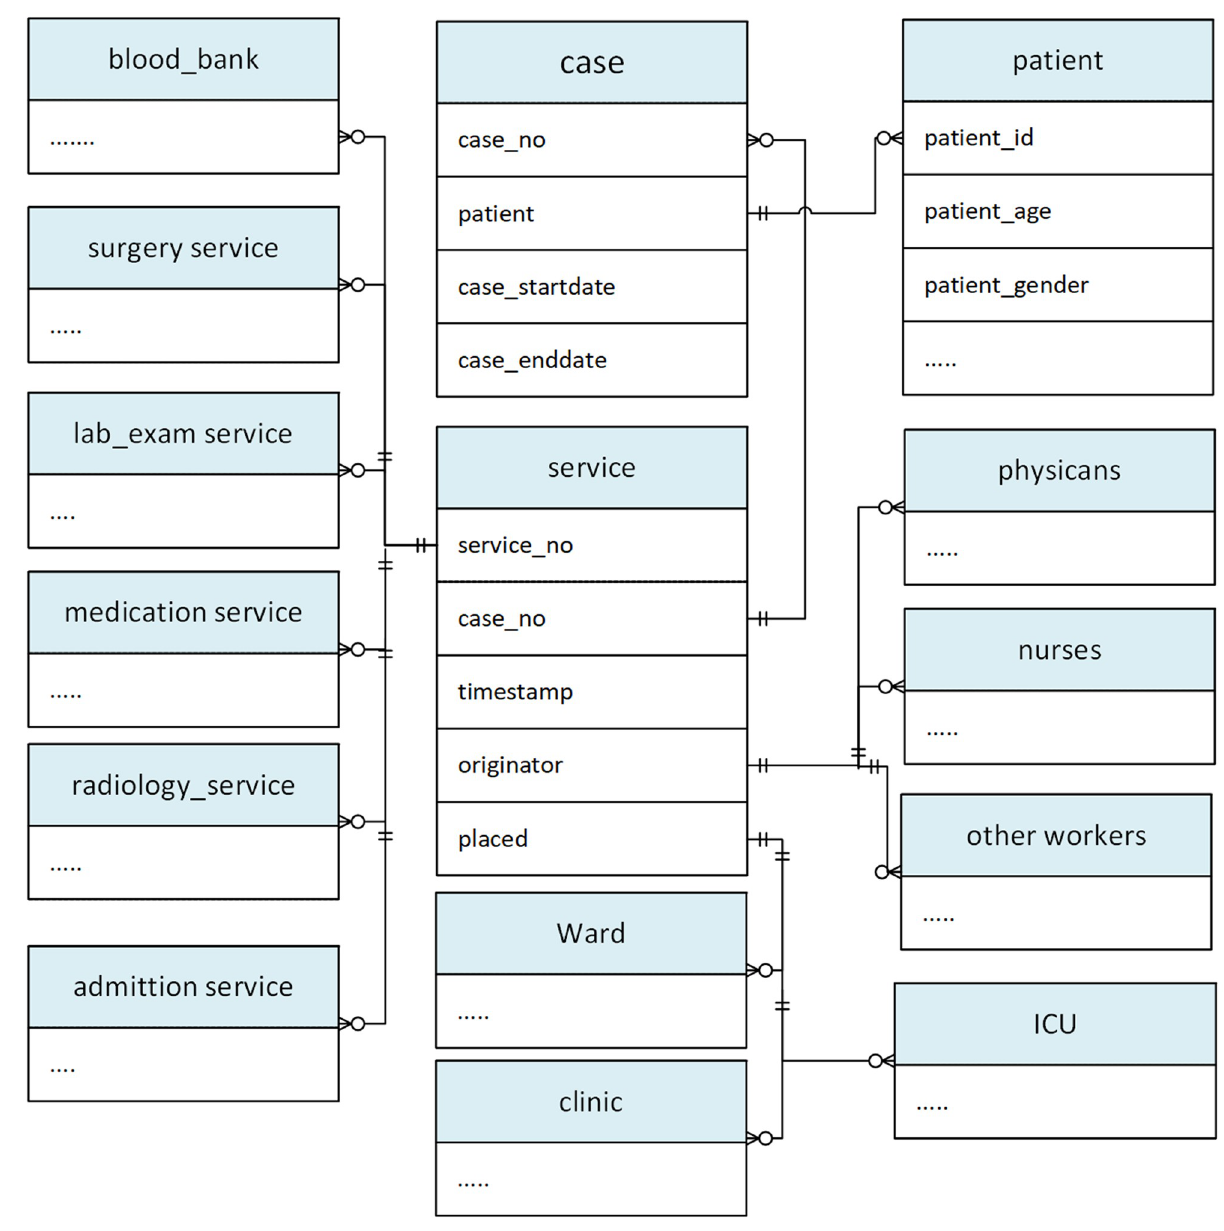
Fig 6. Database model for the case